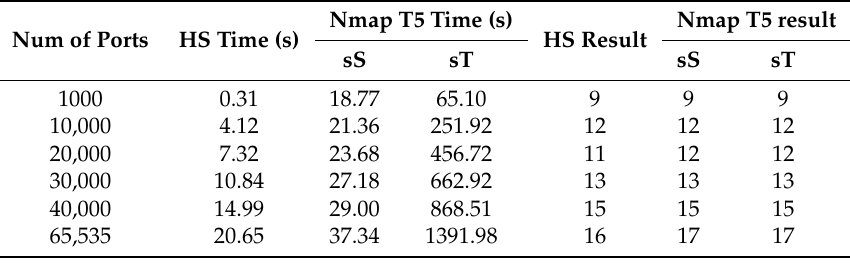
Table 3. The vertical scanning results of HIRFL scanner and Nmap.